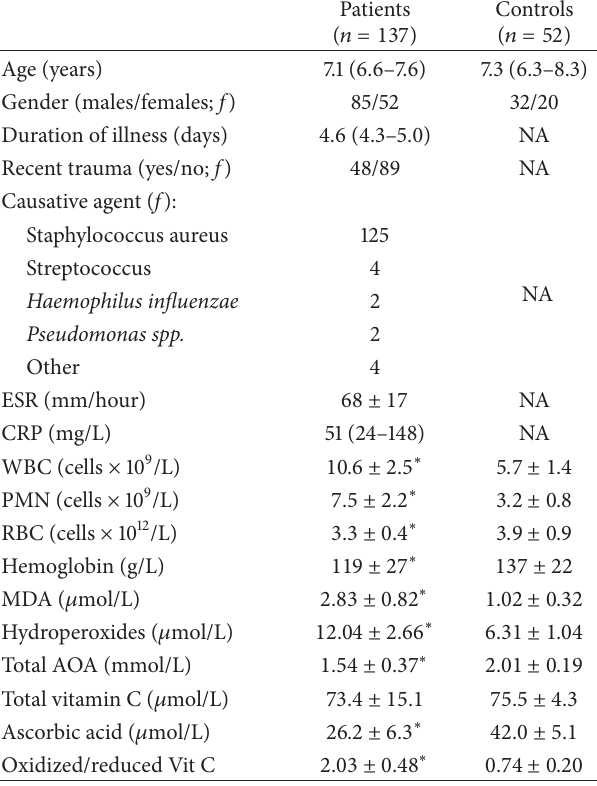
Table 1: Basic demographical, clinical, and laboratory character- istics of patients with acute bacterial osteomyelitis and healthy controls.